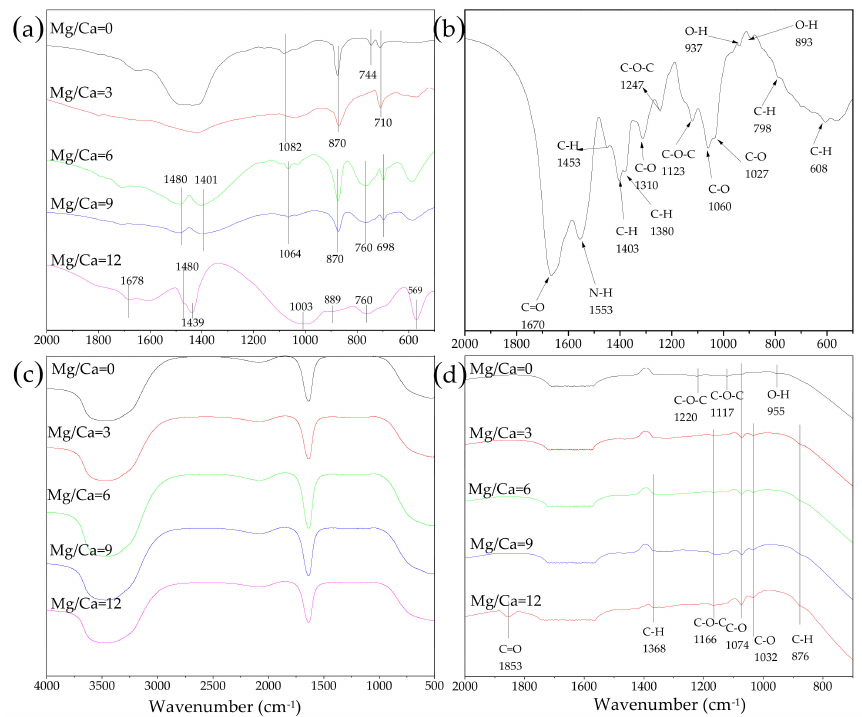
Figure 7. FTIR images of minerals precipitated in the culture mediums at di ff erent Mg / Ca ratios. ( a ) the FTIR patterns of biotic minerals; ( b ) FTIR analysis of EPS; ( c ) FTIR analyses of the supernatant after the minerals have been processed by thorough ultrasonic shaking; ( d ) FTIR analyses of the